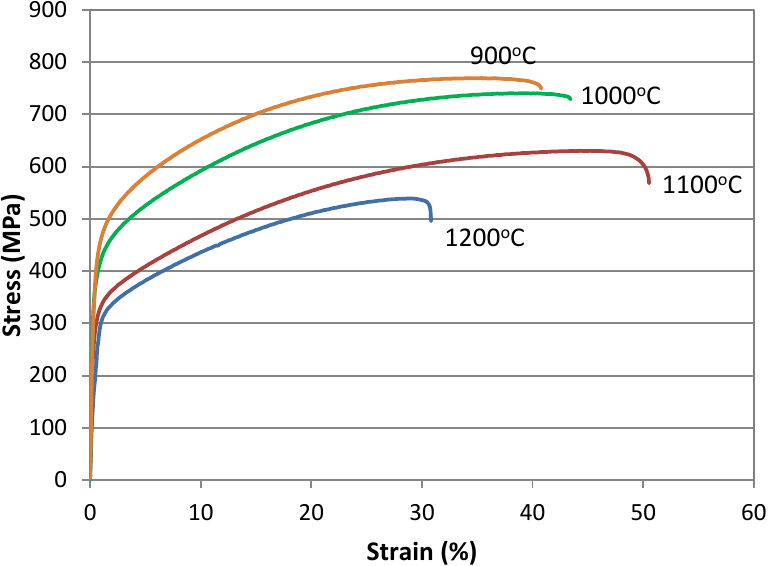
Figure 2. Effect of solution heat treatment temperature on the stress–strain curves registered at different temperatures.